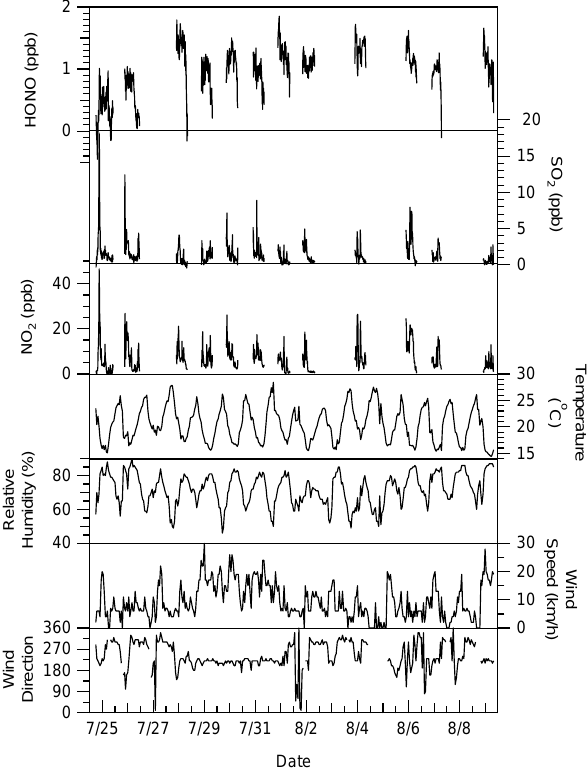
Fig. 2. Chemical and meteorological observations at East Point, Saturna